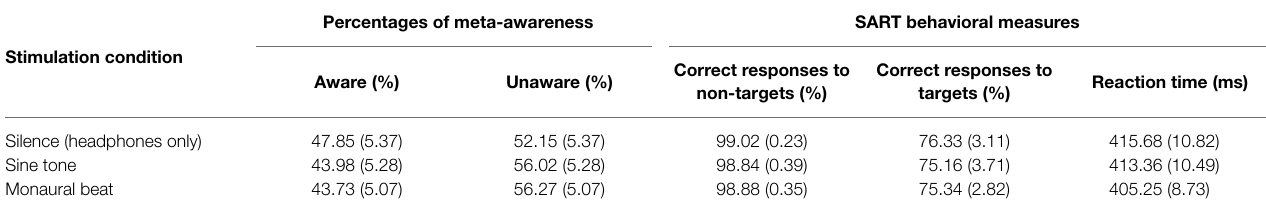
TABLE 1 | Summary of percentages of meta-awareness and SART behavioral